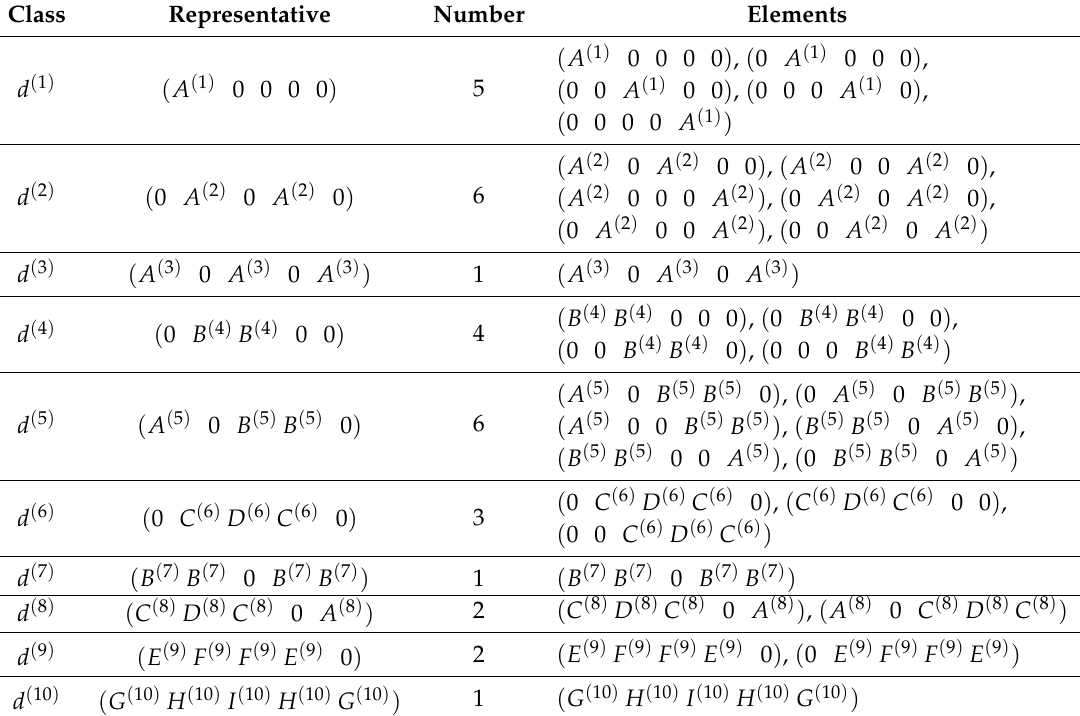
Table 1. Classes of equivalent structures for the extremals of Problem